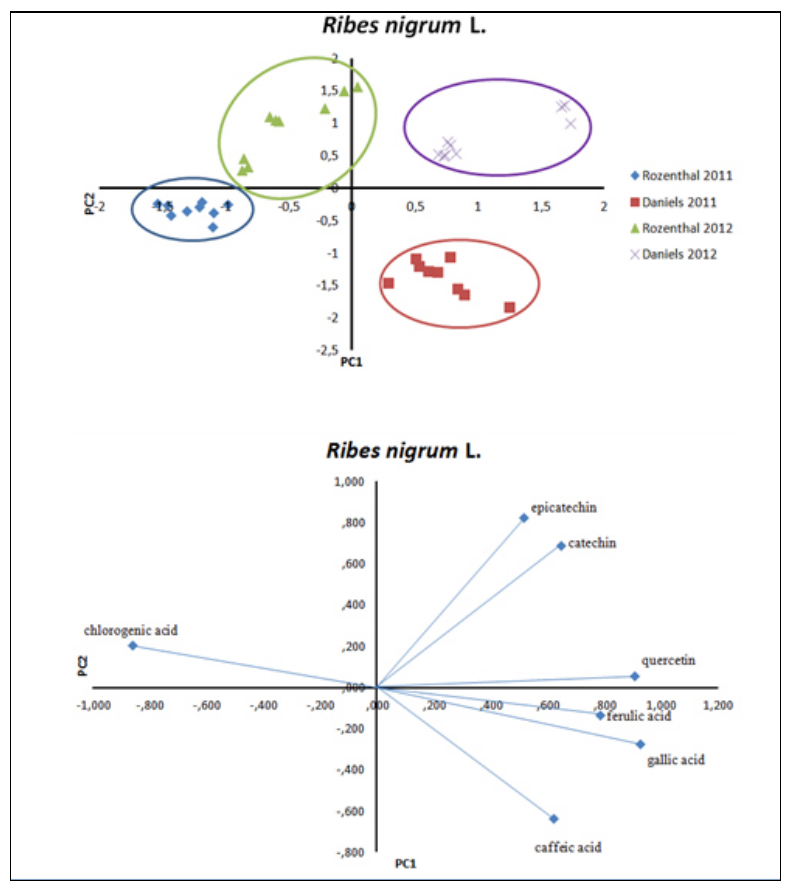
Fig. 5: Ribes nigrum : PCA individual and variable graph of University bud-preparation samples.